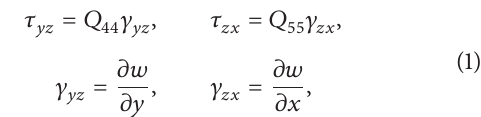
Figure 2: Conformal